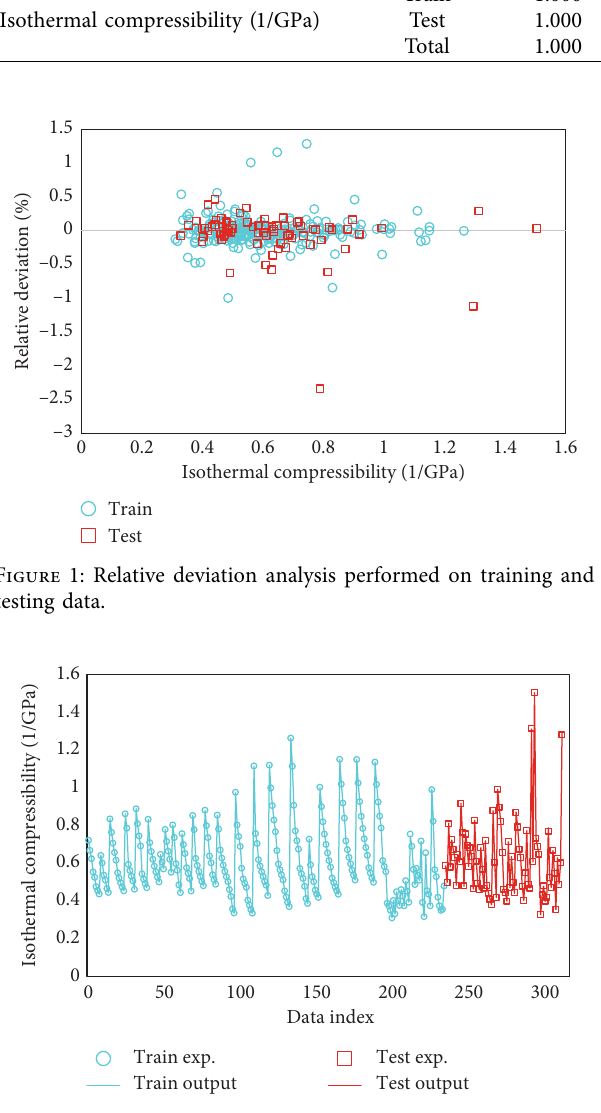
Figure 2: Estimated isothermal compressibility values in com- parison with experimental data using the ELM model.